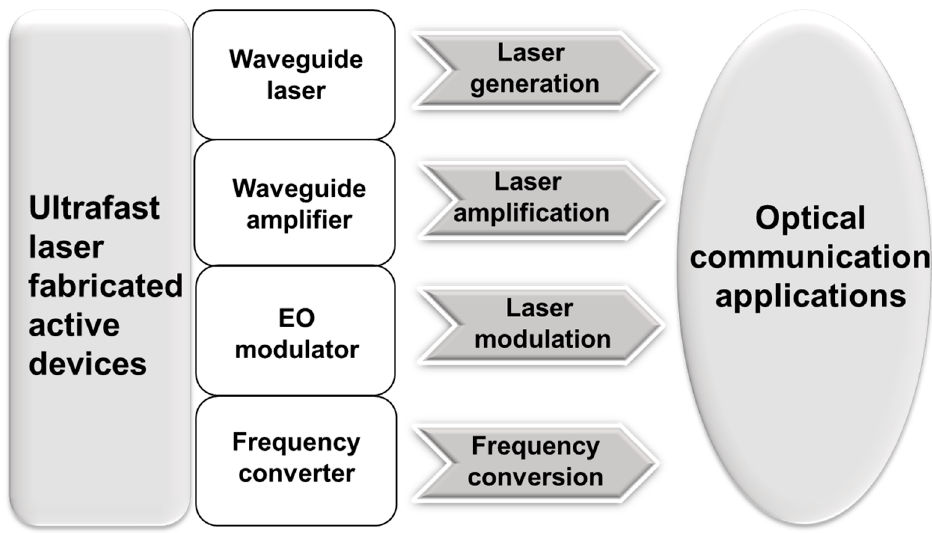
Figure 2. Femtosecond laser-fabricated active devices for optical communication applications.